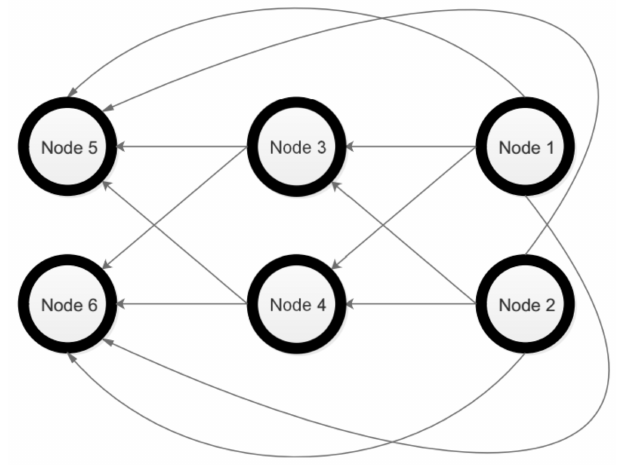
Figure 1. Topology 1 of a SC.